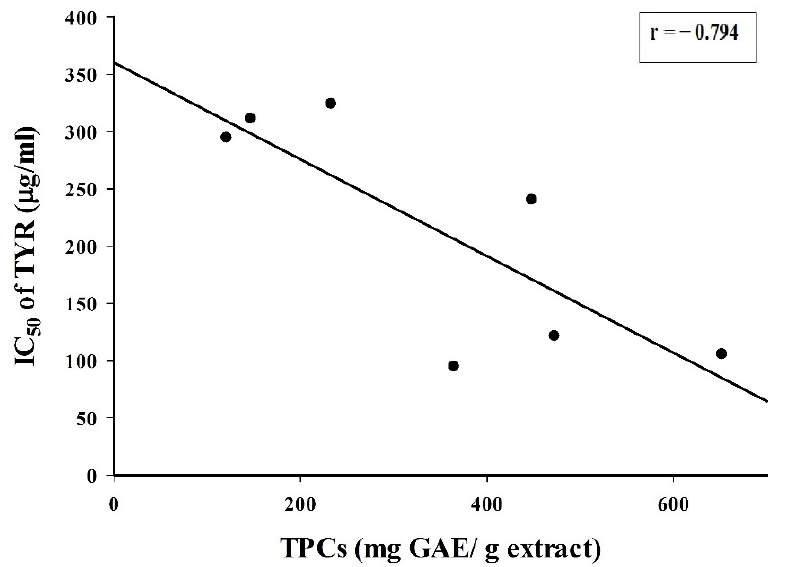
Figure 2. The correlation between TPC and IC 50 of TYR inhibition of plant extracts (r = − 0.78, p < 0.05).